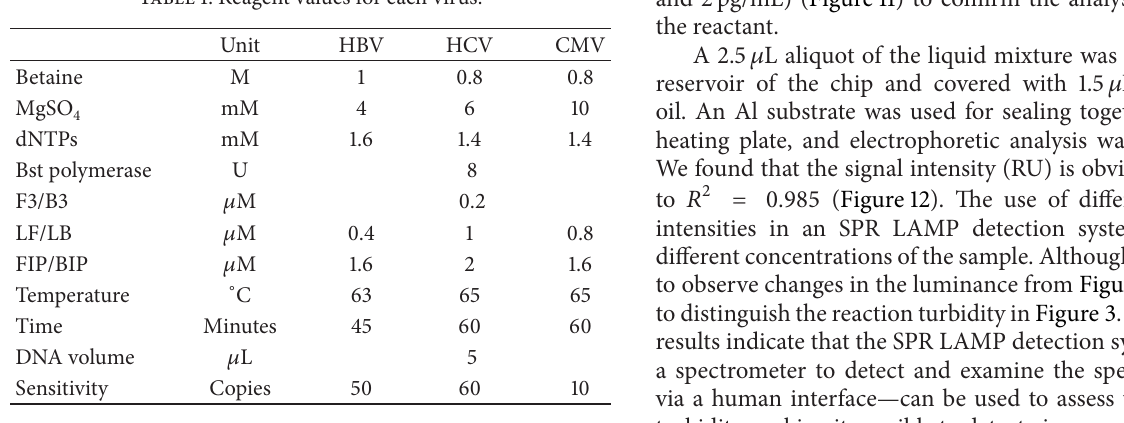
Table 1: Reagent values for each